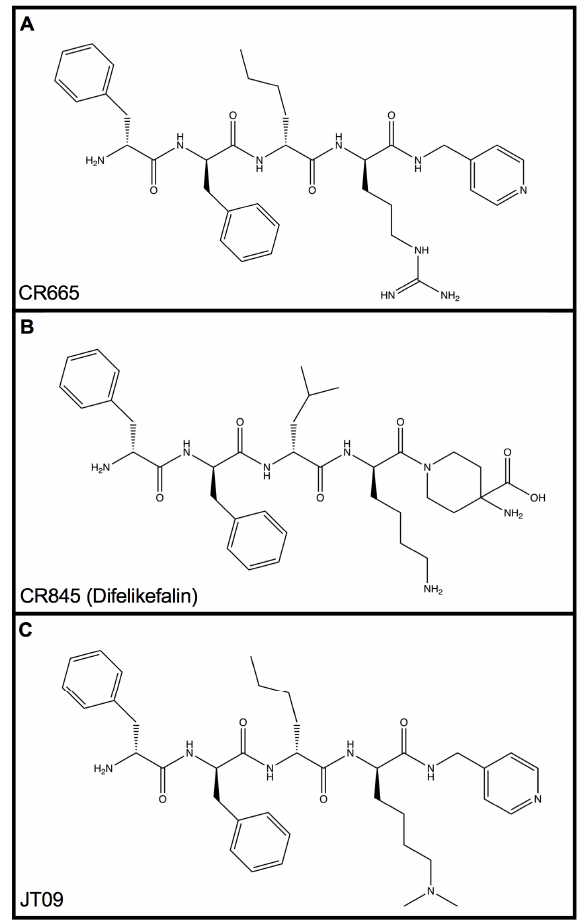
Figure 1. Chemical structures of CR665 ( A ), CR845 ( B ), and JT09 ( C ). The Position 4 D-Arg residue of CR665 was converted to a derivative containing a modified D-Lys residue in JT09.